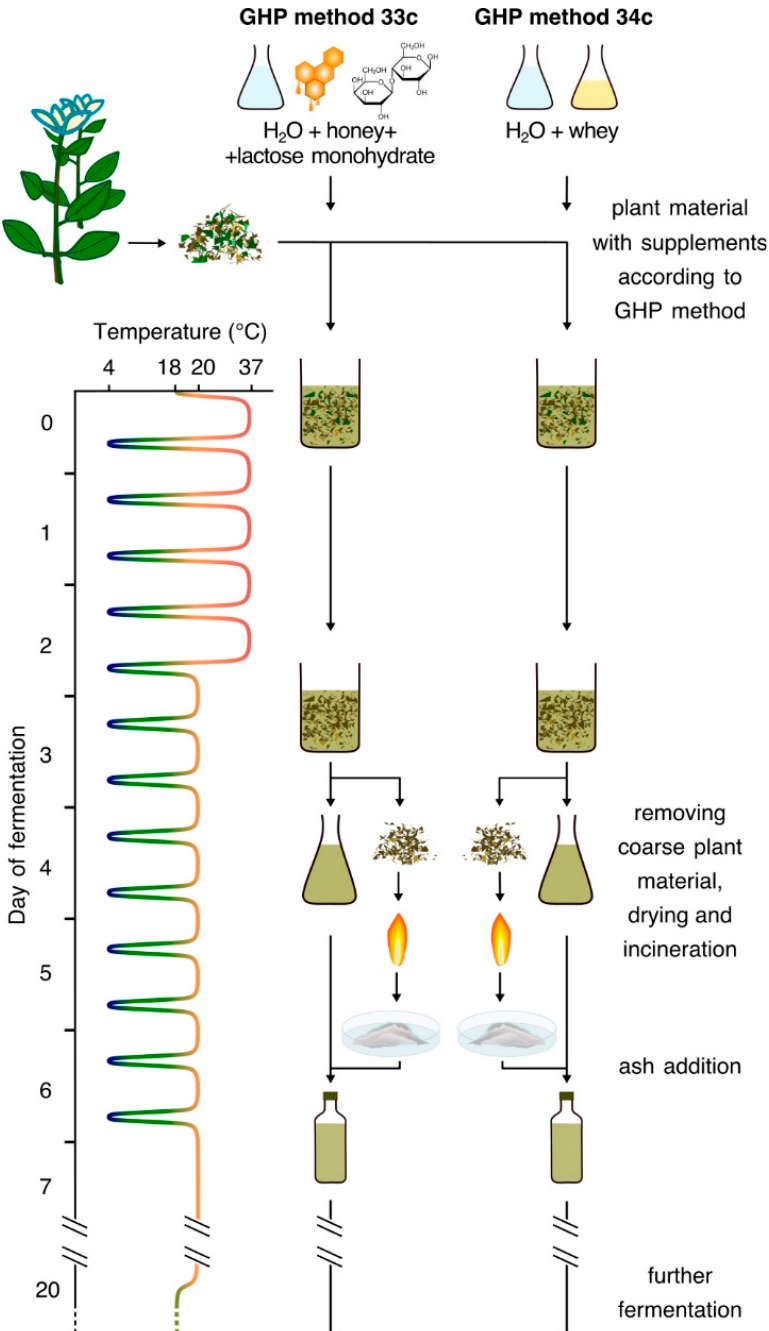
Figure 1. Flowchart of the fermentation, according to GHP methods 33c and 34c, during the first three weeks. Method 33c includes an initial supplementation with honey and lactose, and method 34c includes an initial supplementation with cow whey. Incubation was performed at 37 °C